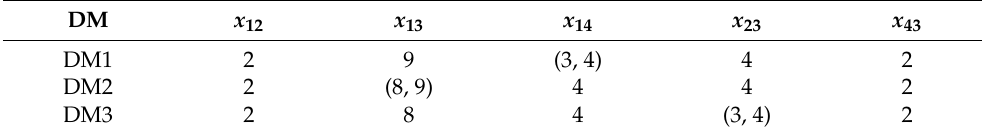
Table 7. Pairwise comparison of three decision-makers in Example